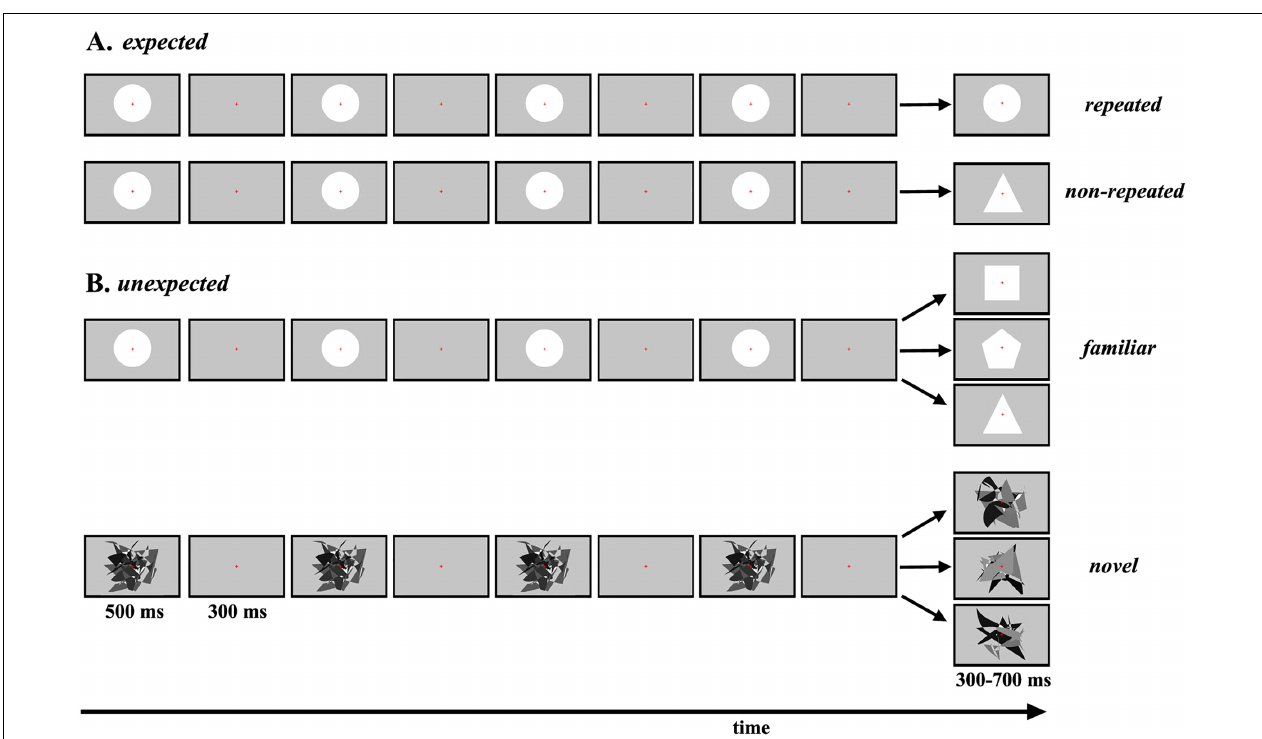
FIGURE 1 | Schematic representation of each experimental condition. (A) The sequence of repeated standard stimuli and the target stimulus presented in each trial in the expected repeated and expected non-repeated conditions. (B) The sequence of repeated standard stimuli and the target stimulus presented on three example trials in the unexpected familiar and unexpected novel